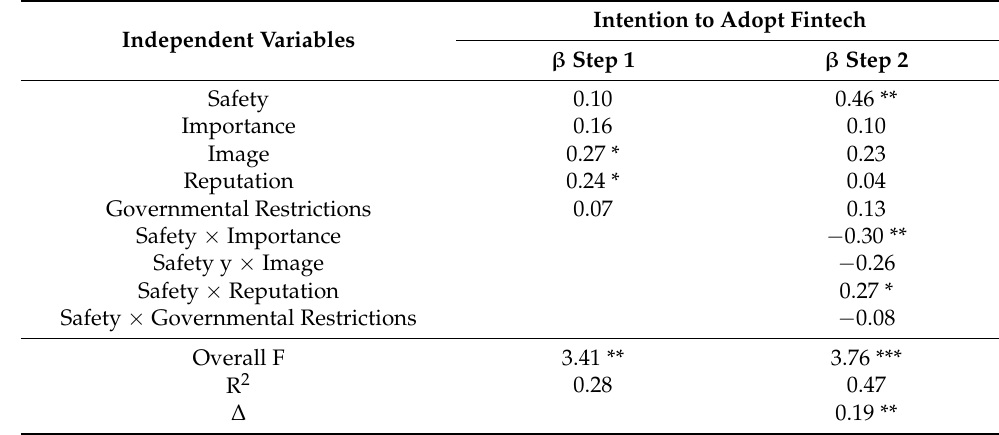
Table 11. Moderating effect of environmental context on the relationship between perceived safety in Fintech services and intention to adopt the Fintech service (Source—IBM SPSS Statistics